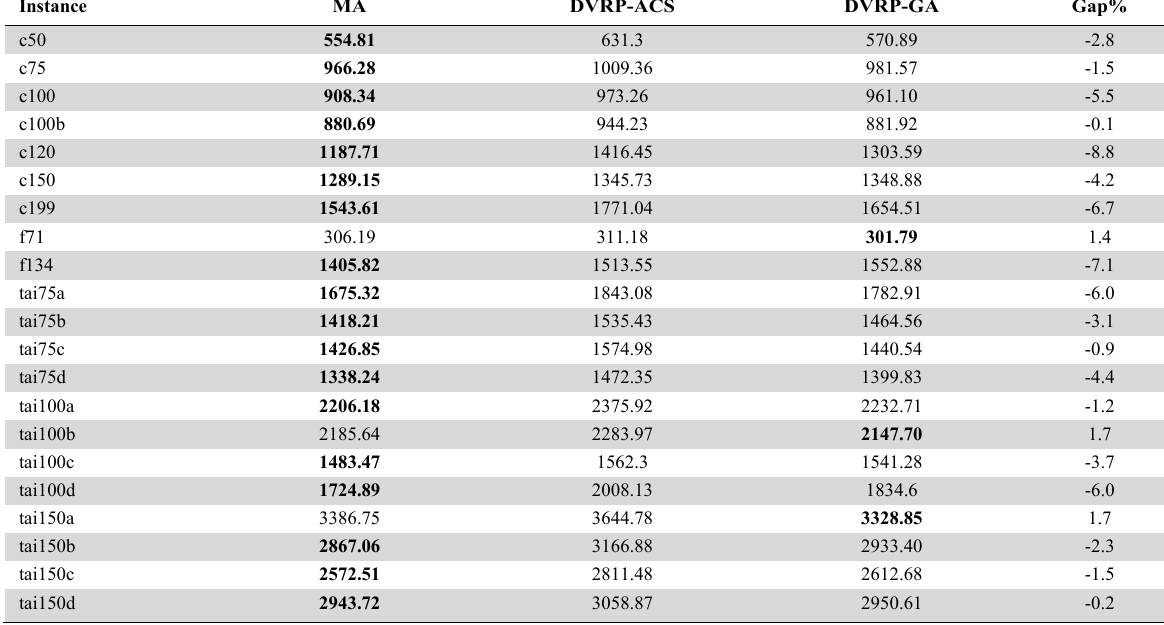
MA results vs DVRP-GA and DVRP-ACS